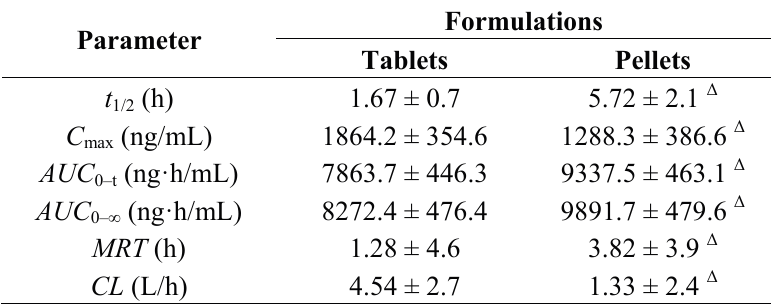
Table 1. Pharmacokinetic parameters of the two